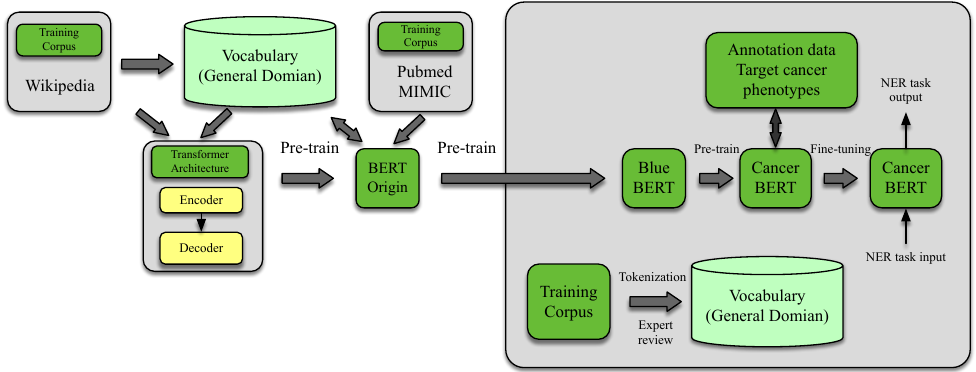
Figure 3. cancerBERT [44] models undergo pre-training on a large corpus of text data such as Wikipedia. Once pre-training is complete, they are then fine-tuned to a specific NLP task where it is trained on a smaller, more specific